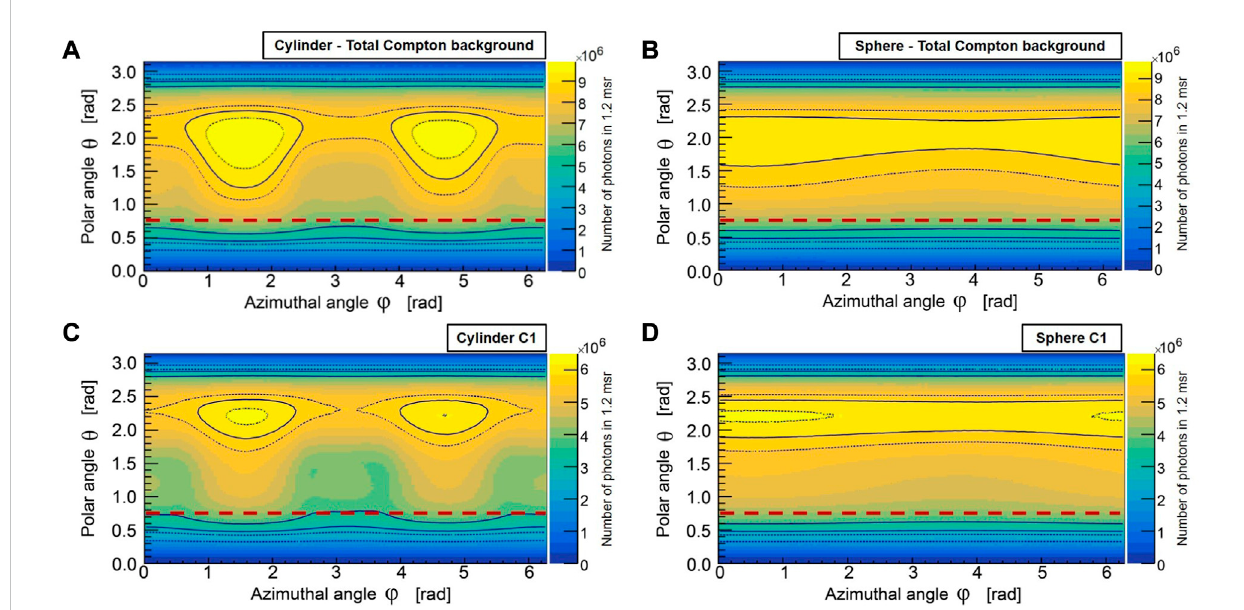
FIGURE 5 The spatial distribution of total Compton (A , B) , and single-Compton (C , D) scattered photons in the Gd K-shell energy range for cylindrical and spherical water phantoms are shown here for a 4 π uncollimated spherical detector (MC). The brown dashed line represents the polar angle of the detector ’ soptical axis ( z -axis of thesensor)with respect to theprimary beam direction. The totalComptonscattering atthe detector ’ soptical axis differs slightly less than a factor of two from the maximum value over the polar angle θ , while the single-Compton scattering differs by a factor of two. The asymmetryobservedin ϕ ,inthecylindricalwaterphantom (A , C) ,arisesfromtheexcesspathlengththatphotonsmusttraversethroughthevolumealong the height of the cylinder compared to its radial direction, resulting in an increased likelihood of higher-order Compton scattering and